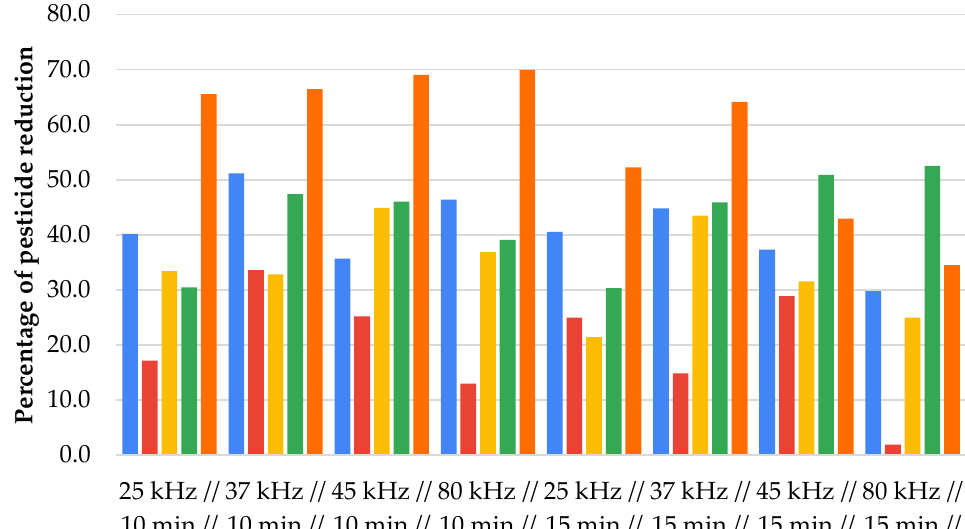
Figure 1. Results for each treatment expressed as percentage of pesticide reduction.